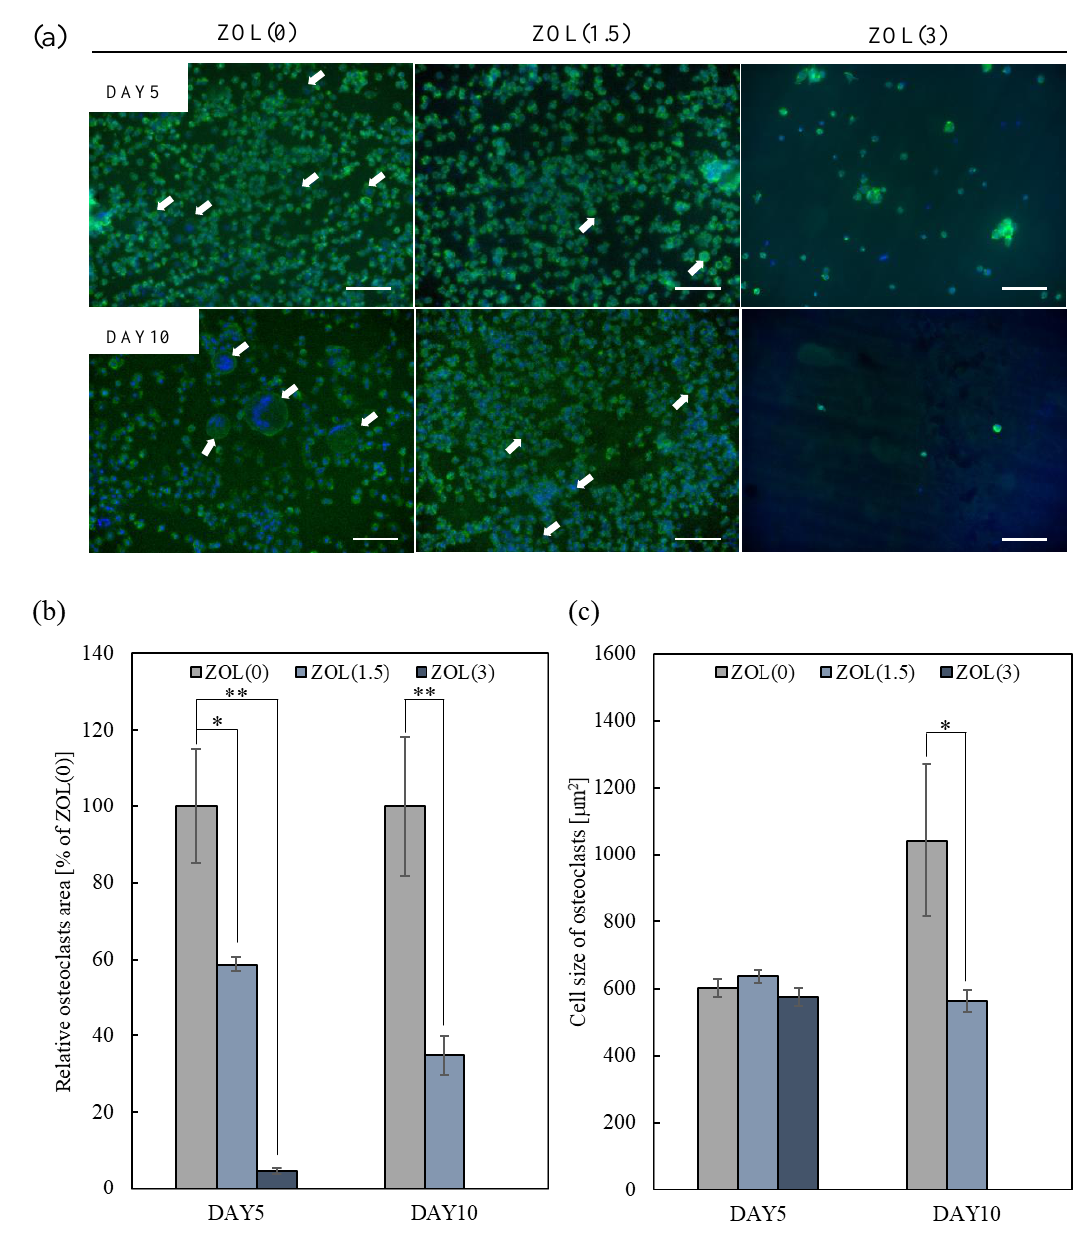
Figure 7. Effect of bound-ZOL for mice bone marrow stromal cells (mBMSCs) differentiation. mBMSCs were cultured on each ZOL/β-TCP disc for 5, 10 days (DAY5, 10). ( a ) Morphological observation of mBMSCs at days 5 and 10. mBMSCs were stained with Alexa Flour ® 488-labeled phalloidin for F-actin (green) and 4’,6-diamidino-2-phenylindole (DAPI) for nuclei (blue) and observed with fluorescence microscopy. White arrows; osteoclasts (cell with more than 2 nuclei), scale bars; 100 μm. ( b ) Relative osteoclasts area and ( c ) cell size of osteoclasts were analyzed by image analyzer. Error bars indicate standard deviation of the mean. The asterisks show * p < 0.05, ** p < 0.01 as compared with ZOL(0) by Student’s t -test.